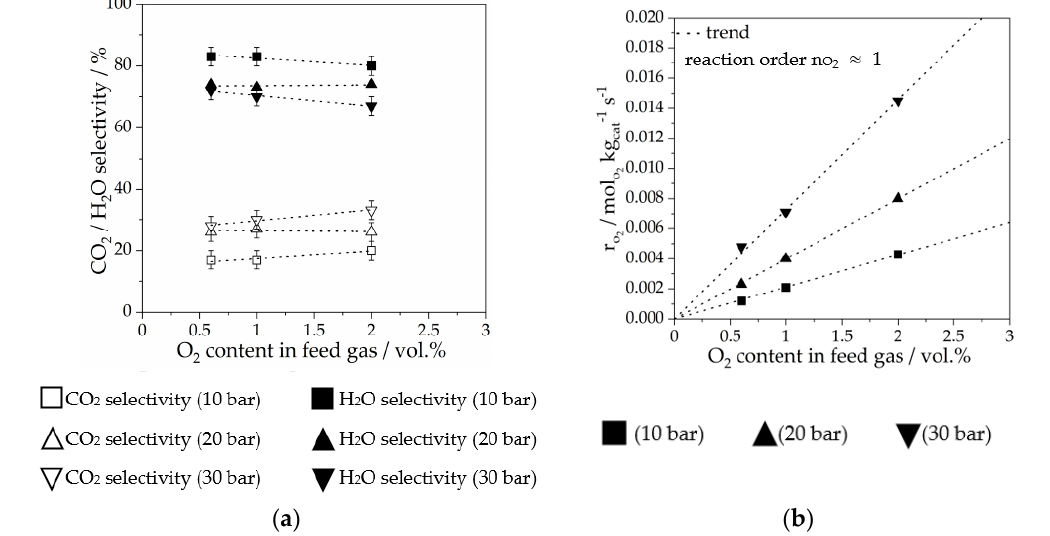
Figure 5. ( a ) CO 2 /H 2 O selectivity vs. O 2 concentration in the FTS with O 2 -containing syngas. ( b ) O 2 consumption rate vs. O 2 concentration in the FTS with O 2 -containing syngas. Conditions: T = 215 °C, p = 10–30 bar; 𝑉(cid:4662) total = 15.9 L/h (NTP); p CO = 1.6–5 bar; p H2 = 3.3–10 bar, p N2+O2 = 5–15 bar; m cat (Co/Pt/Al 2 O 3 ) = 1 g; X CO = 0.02; X O2 = 0.2–0.25.